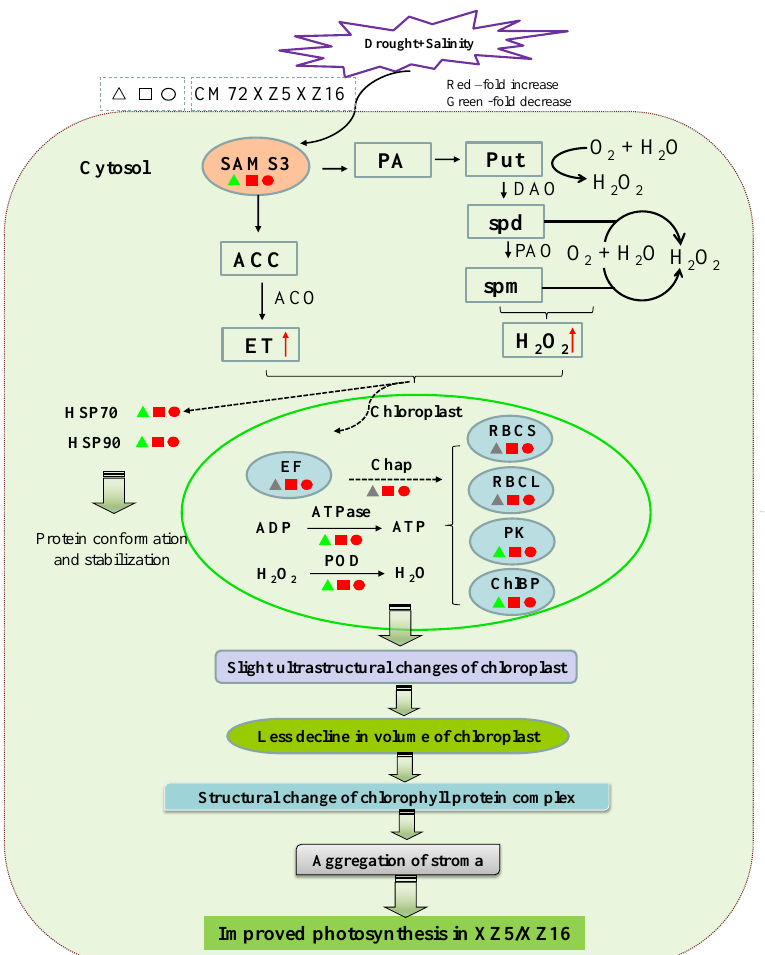
Figure 6. Integrated schematic of the mechanisms involved in the tolerance and adaptation of combined drought and salinity stress in Tibetan wild barley. The proteins in red, gray, and green are upregulated, nonchanged, and downregulated according to Tables 1 and 2, respectively. The red arrows indicate upregulated changes. ACC, S-aminocyclopropane-1-carboxylate; ACO, S-aminocyclopropane-1-carboxylate oxidase; ATPase, ATP synthase subunit beta; Chap, 20 kDa chaperonin; ChlBP, chlorophyll a-b binding protein 1; DAO, diamine oxidase; ET, ethylene; EF, elongation factor Tu; HSP, heat shock protein; PA, polyamine; PAO, polyamine oxidase; PK, phosphoribulokinase; POD, peroxiredoxin-2E-2; Put, putrescine; RBCL, ribulose bisphosphate carboxylase large chain; RBCS, ribulose bisphosphate carboxylase small chain clone 512; SAM, S-adenosyl-L-methionine synthetase; spd, spermidine; spm, spermine. Moreover, slight ultrastructural changes in chloroplasts lead to a lower chloroplast volume, aggregation of stroma, structural changes in chlorophyll protein complex, and improved ATP synthesis.